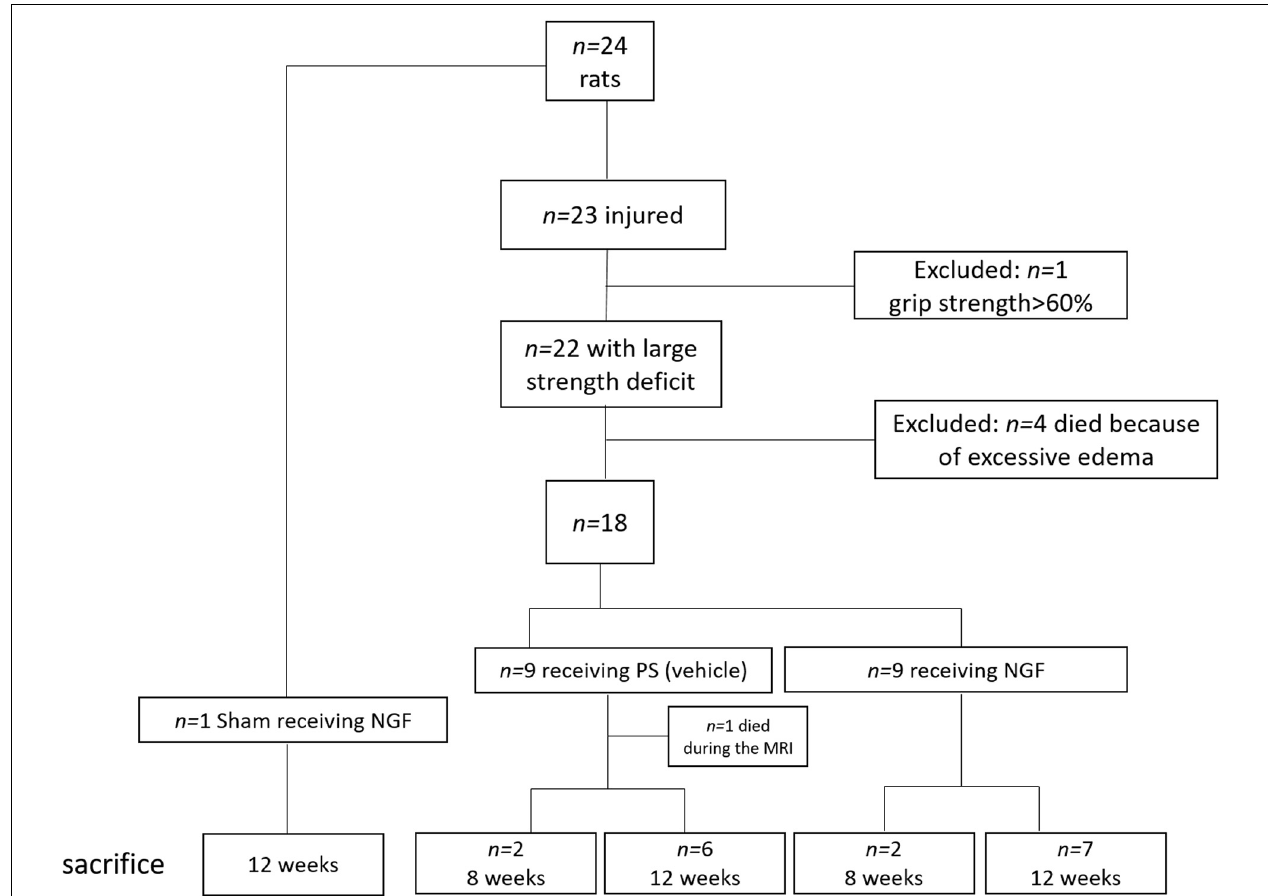
FIGURE 1 | Flowchart of the study, with the details on the rats excluded from the protocol: n = 4 died after the surgery (excessive edema); n = 1 excluded because of light deficit and performance > 60% at the grip strength test. Rats were sacrificed at 8 weeks ( n = 2 per group) and 12 weeks ( n = 7 per group) to evaluate the presence of reconstructed tissue at the different time points. PS: physiological saline; NGF: nerve growth factor; MRI: Magnetic Resonance